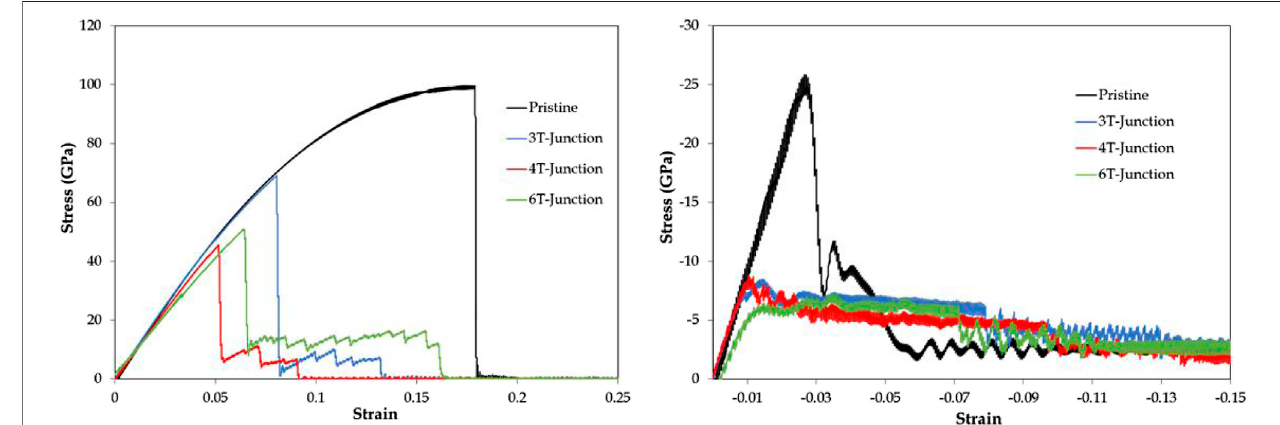
FIGURE 15 | Stress-strain curve of a multi-terminal junction.